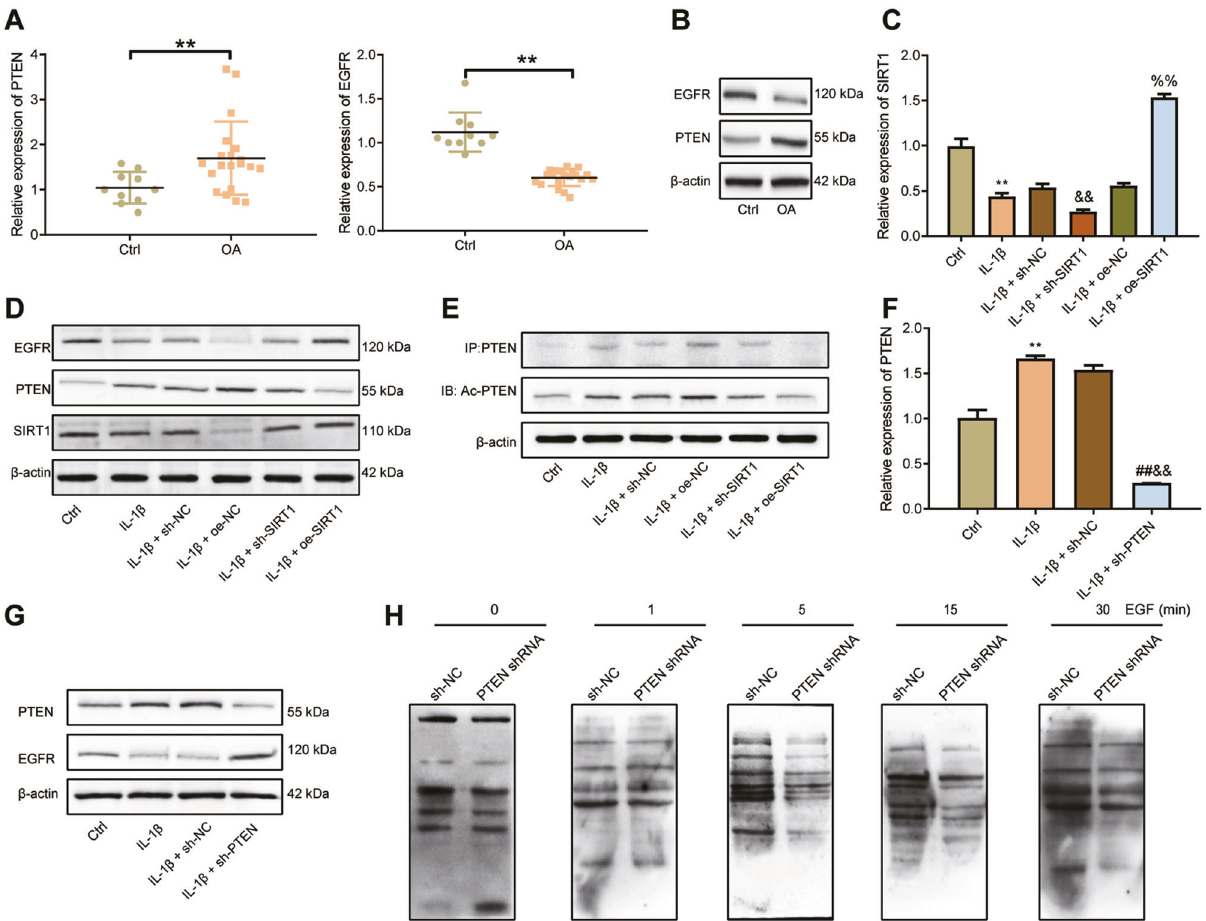
( n = 10) and OA ( n = 20) cartilage tissues. C qRT-PCR detection of SIRT1 transduction ef fi ciency in IL-1 β -challenged primary human chondrocytes. D Western blot detection of expression levels of SIRT1, PTEN and EGFR proteins in IL-1 β -challenged primary